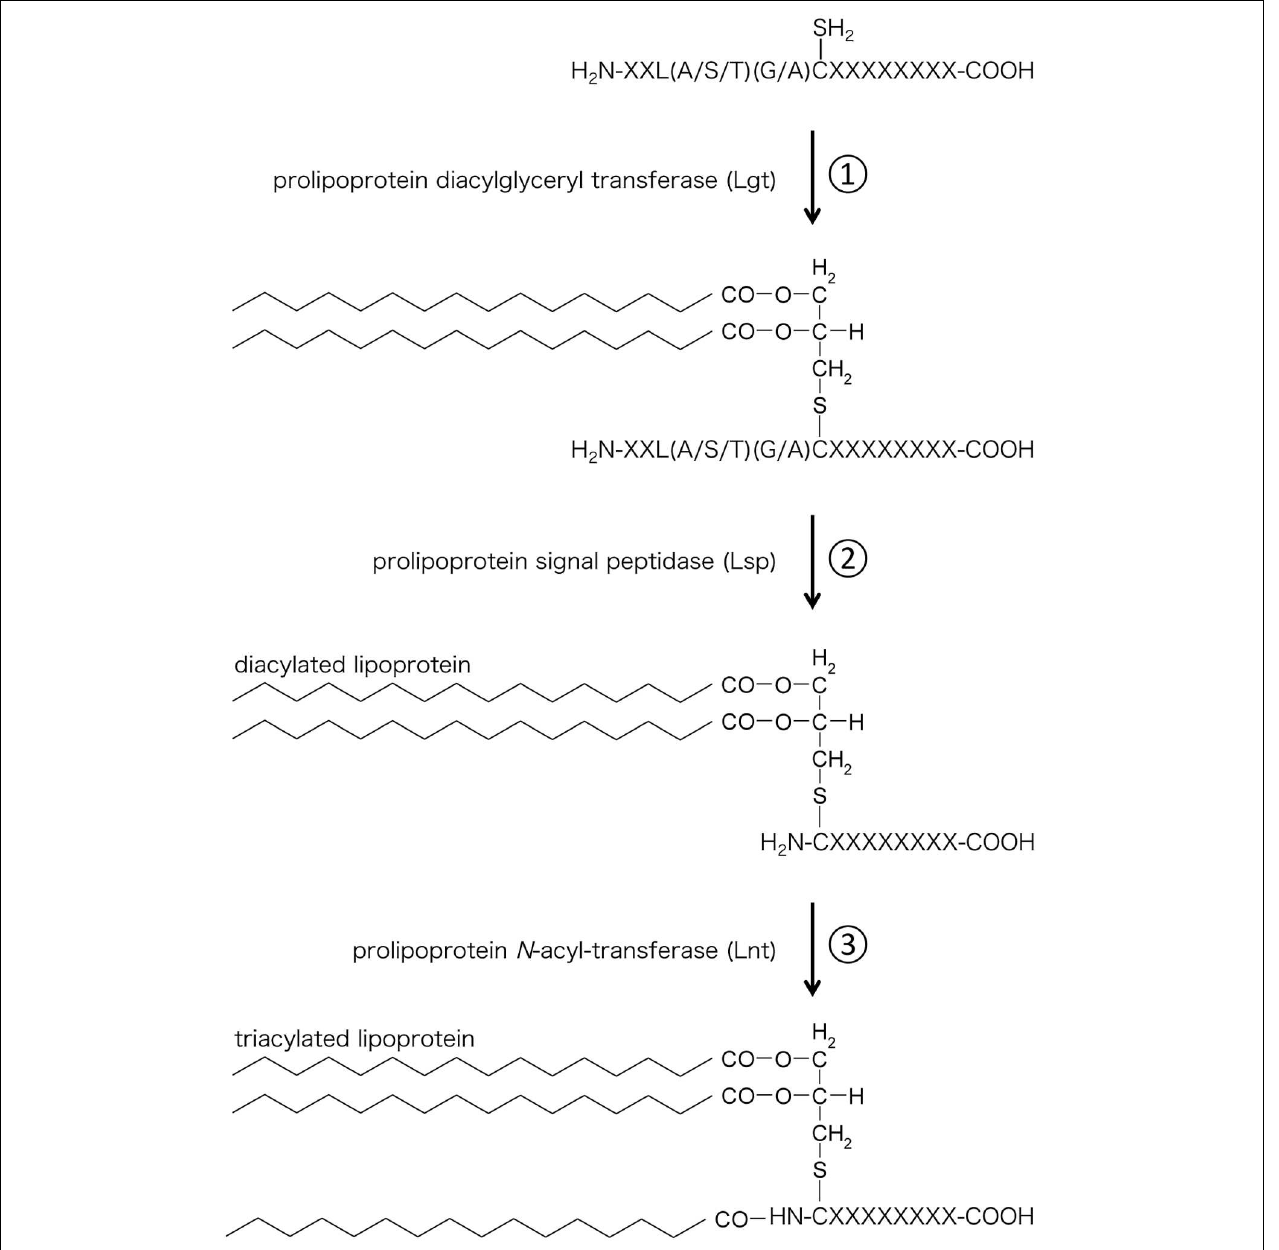
FIGURE 1 | Biosynthesis of bacterial lipoproteins. (1) Lgt transfers a diacylglyceryl moiety from a phospholipid to the sulfhydryl group of the cysteine located after the lipobox sequence. (2) Lsp cleaves the signal peptide at the N-terminus of the cysteine. (3) Lnt transfers an acyl chain derived from phospholipid to the amino group of the